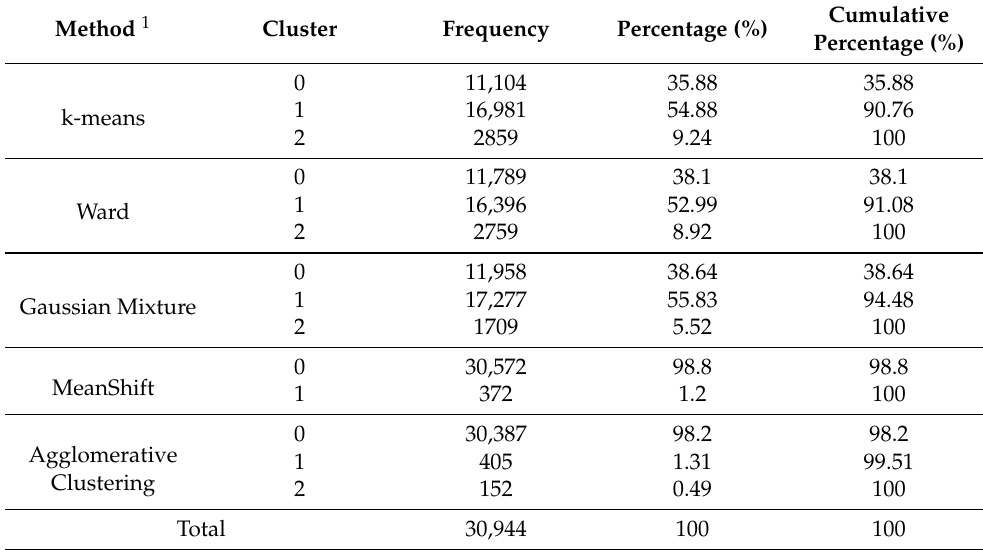
Table 4. Frequency of clusters under different clustering